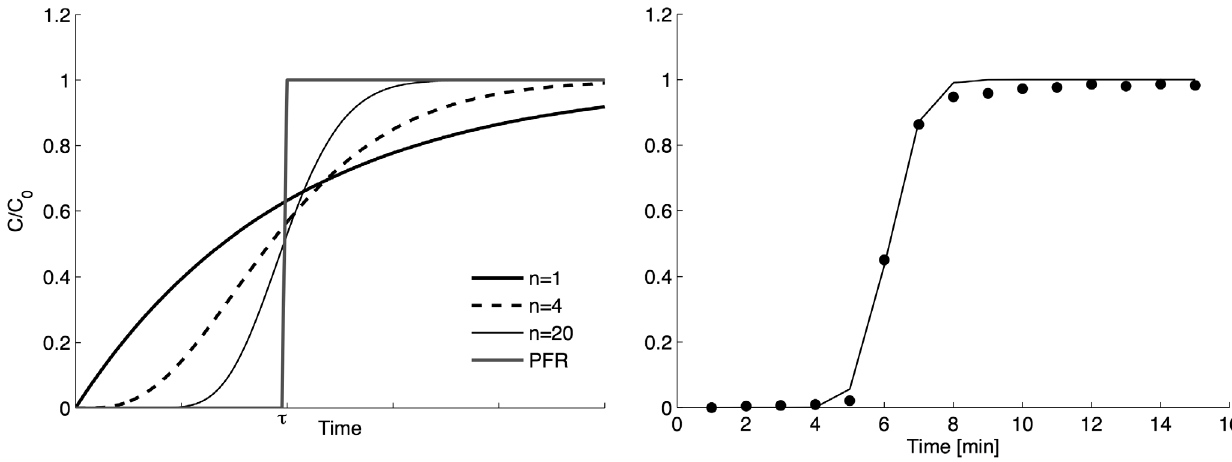
Figure 2. Theoretical step response RTDs and determination of minimal axial dispersion in the experimental layout. Left: Theoretical step response RTD for different numbers (n) of continuous stirred tanks reactors (CSTRs) in series. Plug flow reactor (PFR) configuration (no axial but perfect radial mixing) is approached as the number of CSTRs tends to infinity. Right: Experimental step response RTD (plain circles) after passage through a length of silicone rubber tubing of similar dimensions and flow rate to those of the isolated proximal duodenum. The line of best fit was for 68 CSTRs in series (R 2 =0.99, plain line).